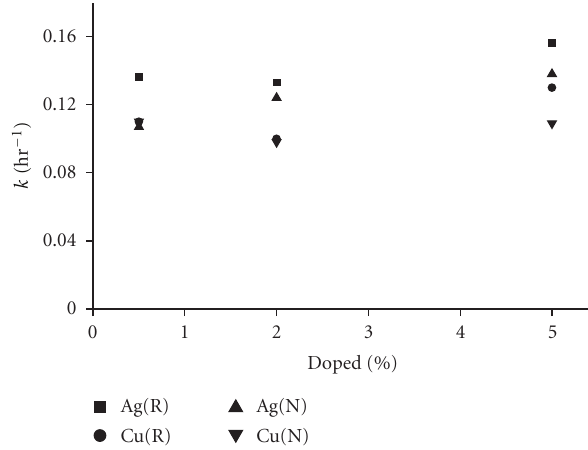
Figure 8: Relationship of the rate constant on the photocatalytic reduction by modified TiO 2 .